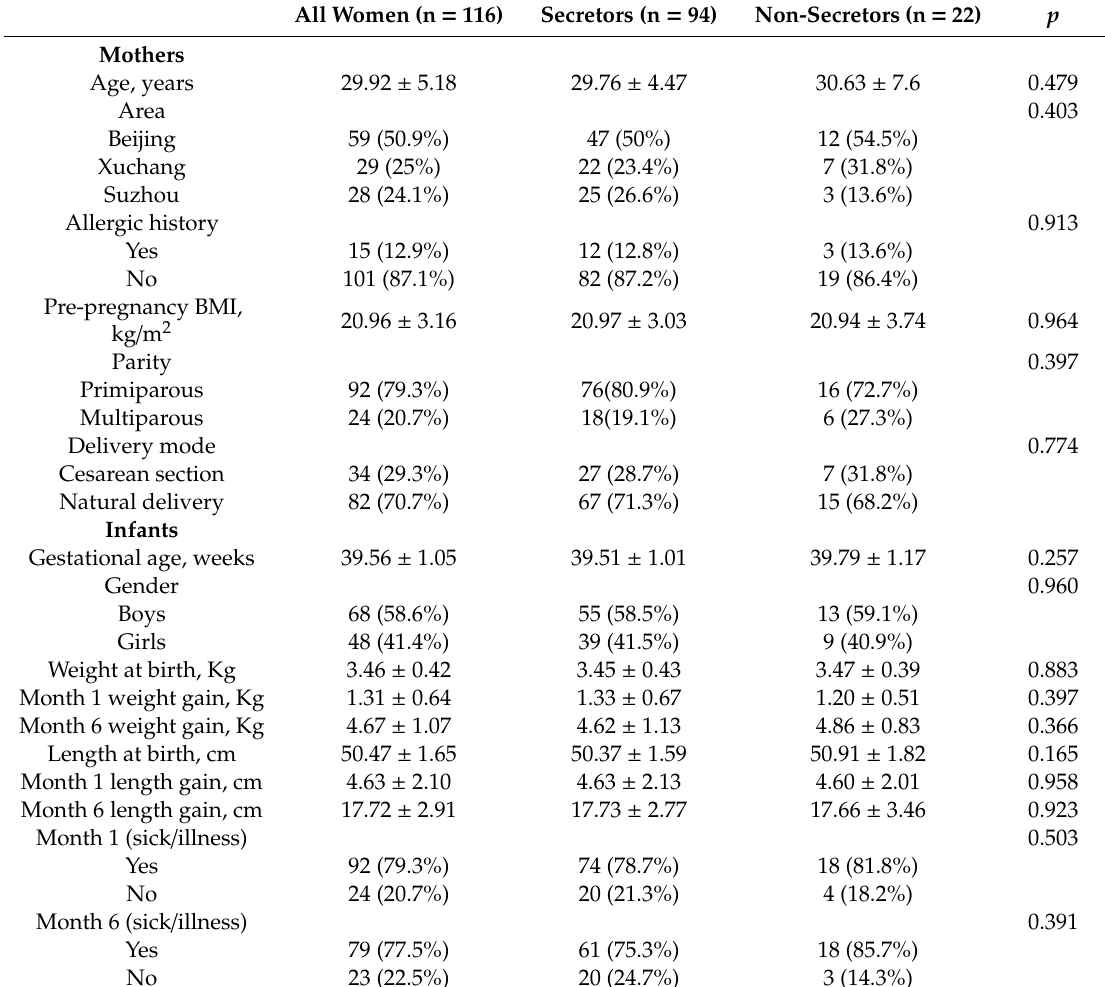
Table2. Characteristicsofstudypopulation, segregatedbySecretorstatus. Mean ± SDorN(Percentage). All Women (n =